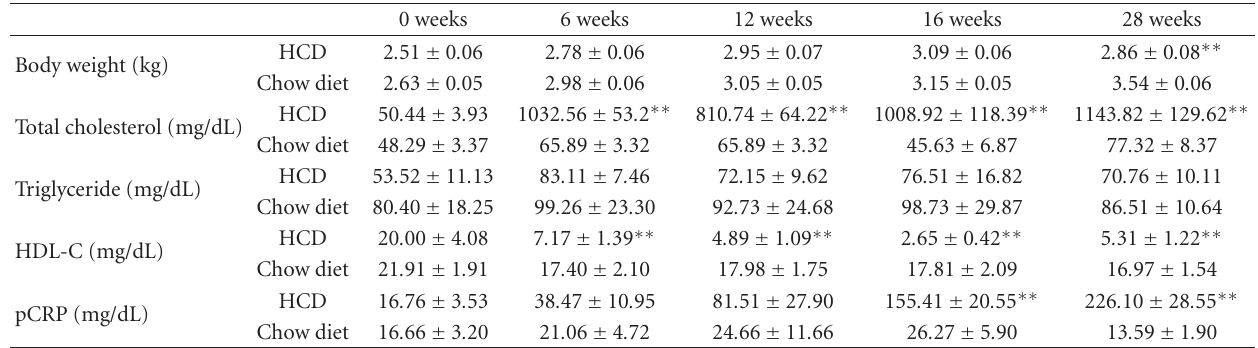
Table 1: Body weight, plasma lipid profiles, and inflammatory